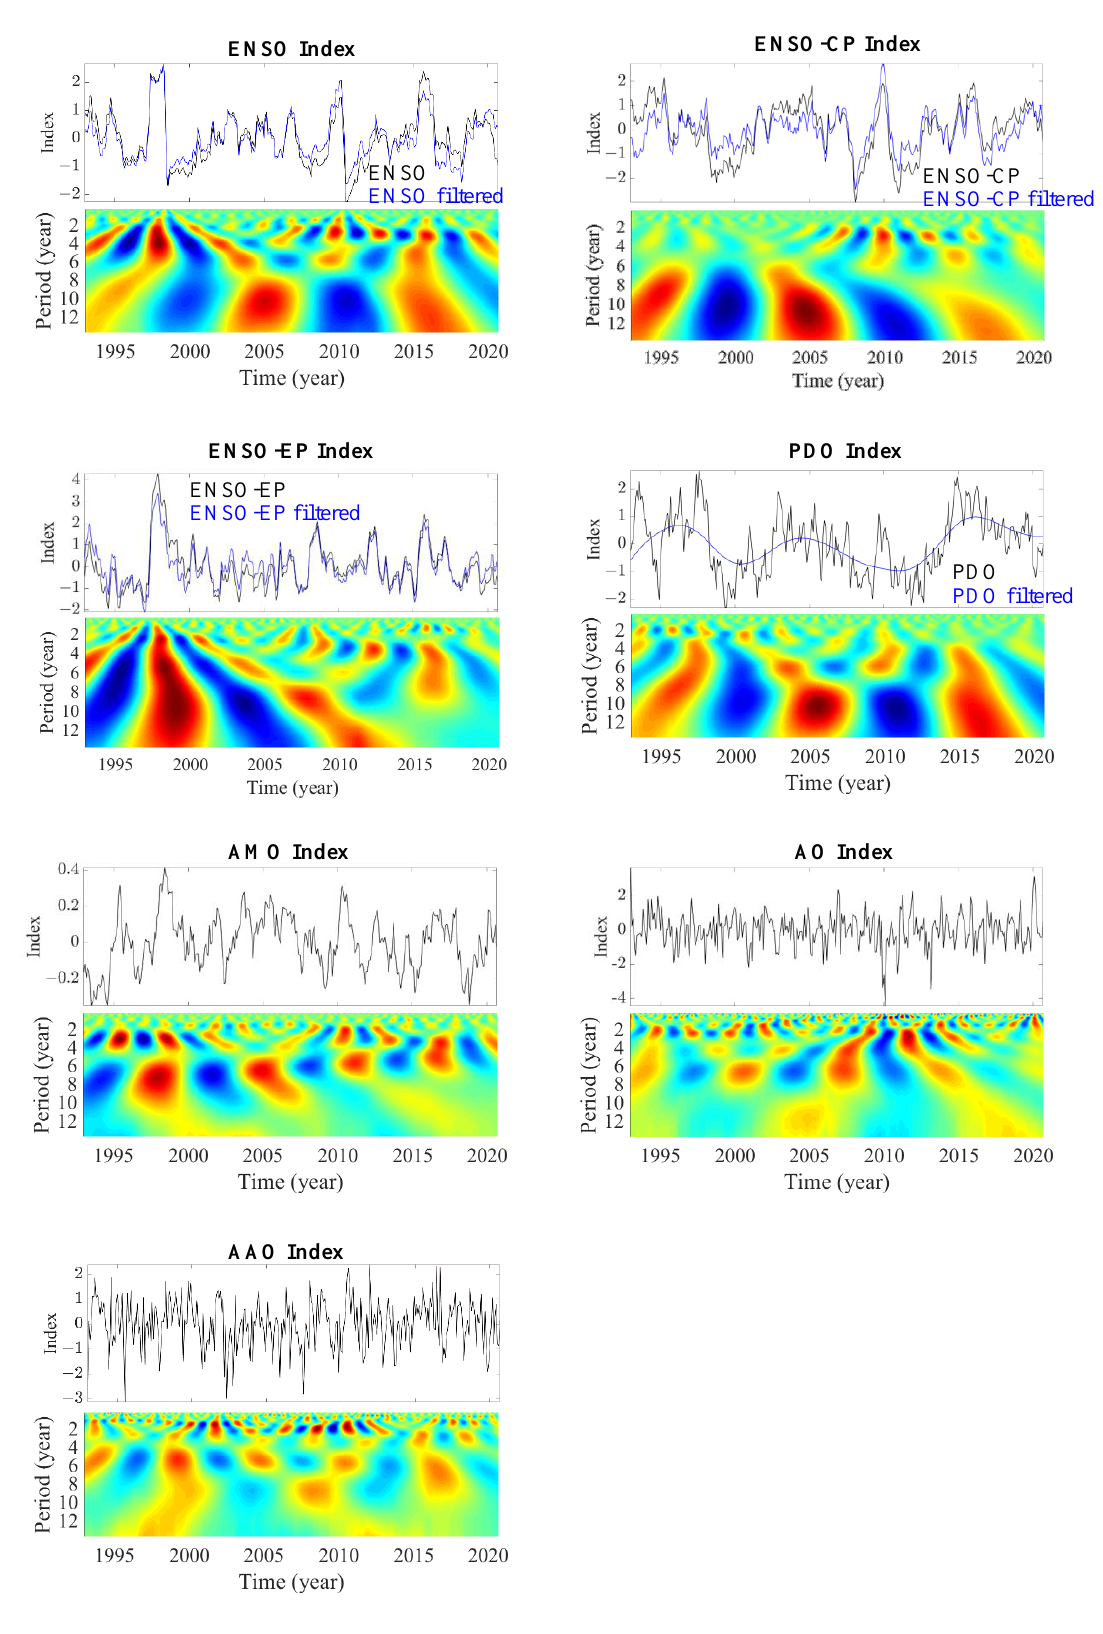
Figure 2. Time series of the various climatic oscillation indices used in this study and their (real- valued) Morlet time–frequency wavelet spectra (blue curves are the high- or low-pass filtered versions; see